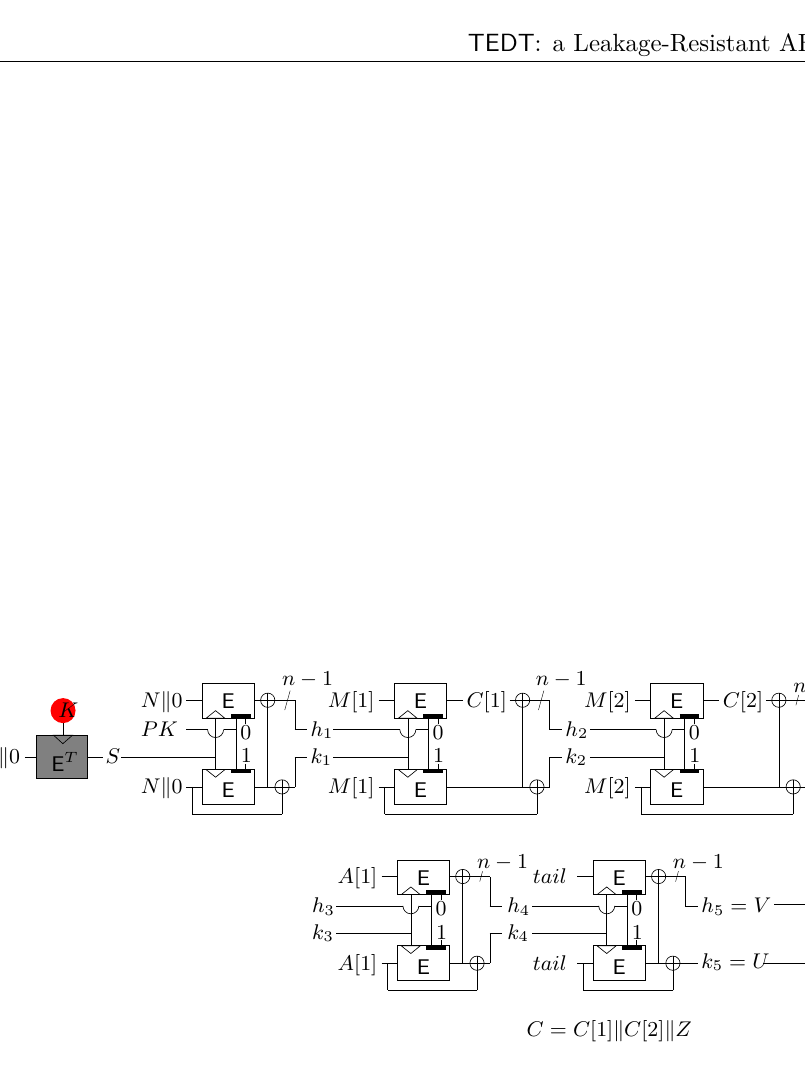
Figure 15: Illustrating the TET AEAD. The two dark blocks are “leak-free” TBC-calls. The other TBC-calls are leaking. For each square, the input to the triangle denotes the key input. The “tail” block is tail = [ | M | ]